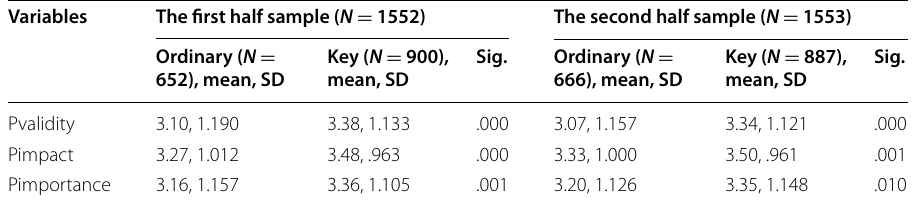
Table 2 T -test of students’ perceptions by school status across two halves of samples Variables The first half sample ( N =